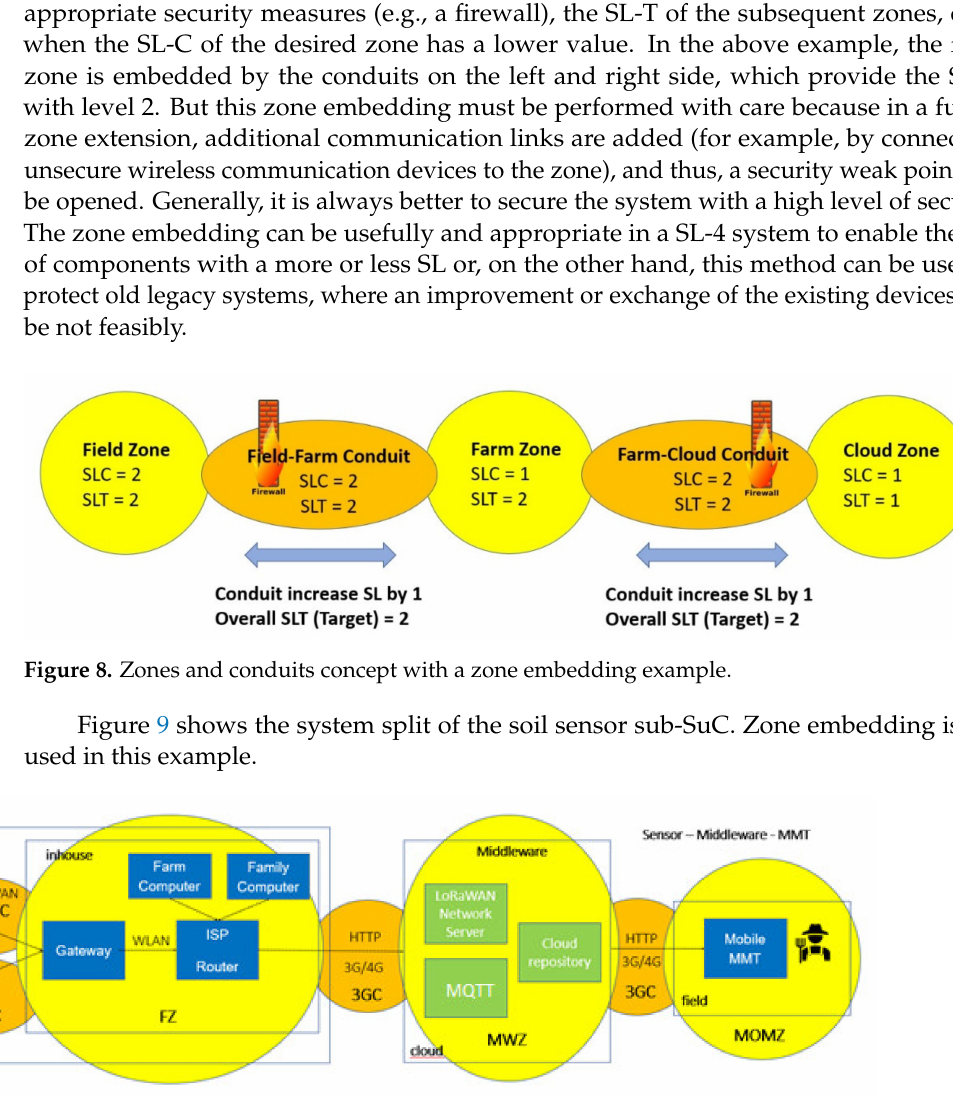
Figure 9. Zones and conduits of soil-sensor